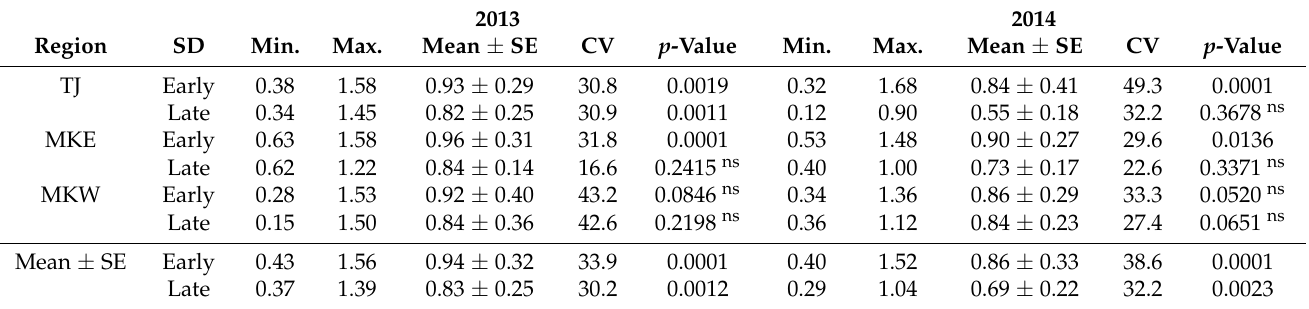
Table 6. Variations of mean potential yield (t/ha at 14% moisture content) of Chadian dry-season sorghum from three regions sown early and late at the You é research farms, Chad, in 2013 and 2014.